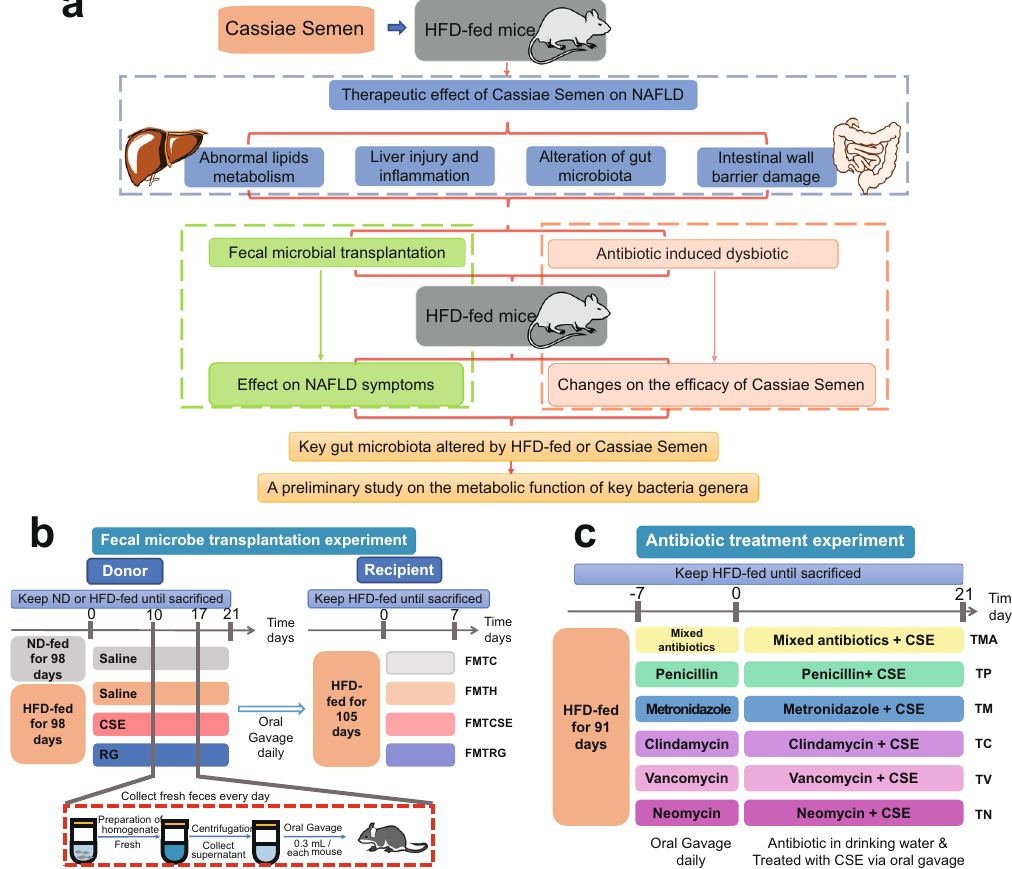
Fig. 1 Research concepts and experimental design. Three components studies were designed to verify our hypothesis ( a ). Experimental design of fecal microbe transplantation (FMT) ( b ) and antibiotic-induced dysbiosis studies ( c ). ND normal diet, CSE Cassiae Semen extract, RG Rubrofusarin-6- β - gentiobioside. FMTC, FMTH, FMTCSE, and FMTRG were the treatment groups receiving fecal microbial transplantation of mice in groups of control, HFD, CSE, and RG, respectively. TMA, TP, TM, TC, TV and TN denoted the groups treated with antibiotics mixture antibiotics, penicillin, metronidazole, clindamycin, vancomycin, and neomycin,